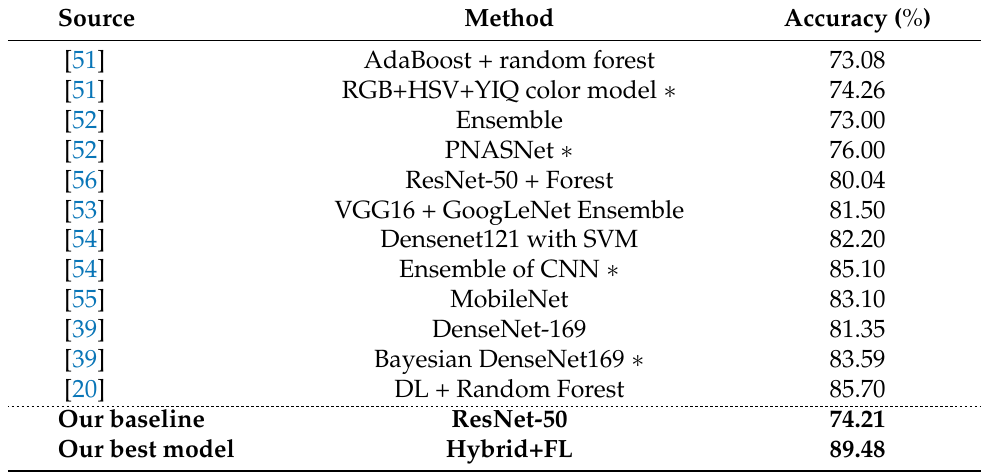
Table 3. the International Skin Imaging Collaboration (ISIC) 2018 and Human Against Machine with 10,000 training images (HAM10000) datasets. The asterisk ( ∗ ) sign on some models shows that auxiliary processing stages and methods were exploited to improve the performance. Our models are given in bold. ANN = artificial neural network; CNN = convolutional neural network; FL = focal loss; ML = machine learning; SVM = Support Vector